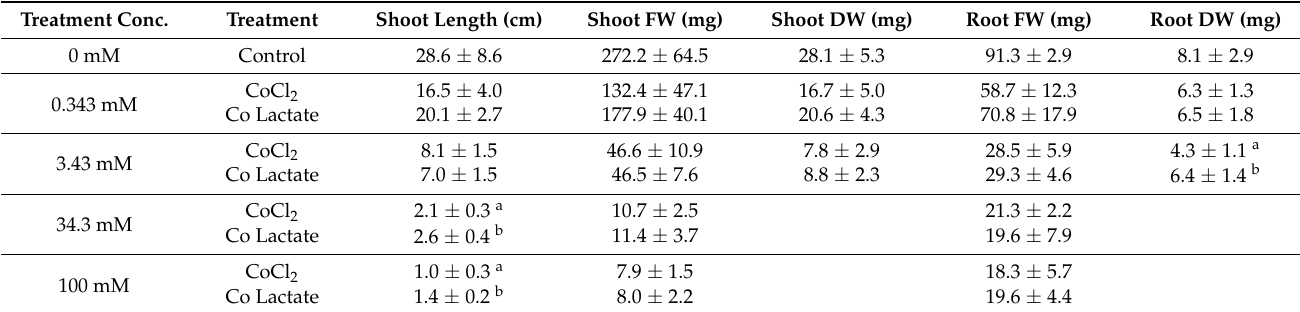
Table 9. Plant growth parameter results for cobalt (Co) treatments. After 13 days of growth, wheat seedlings were harvested, and shoot length was measured along with fresh weight (FW) and dry weight (DW) of both root and shoot tissue. A t -test was used to identify differences between cobalt chloride and cobalt lactate treatments within each treatment level for each plant growth parameter, where superscripts “a” and “b” denote treatment differences of p < 0.05. ± : standard deviation. Treatment Conc.